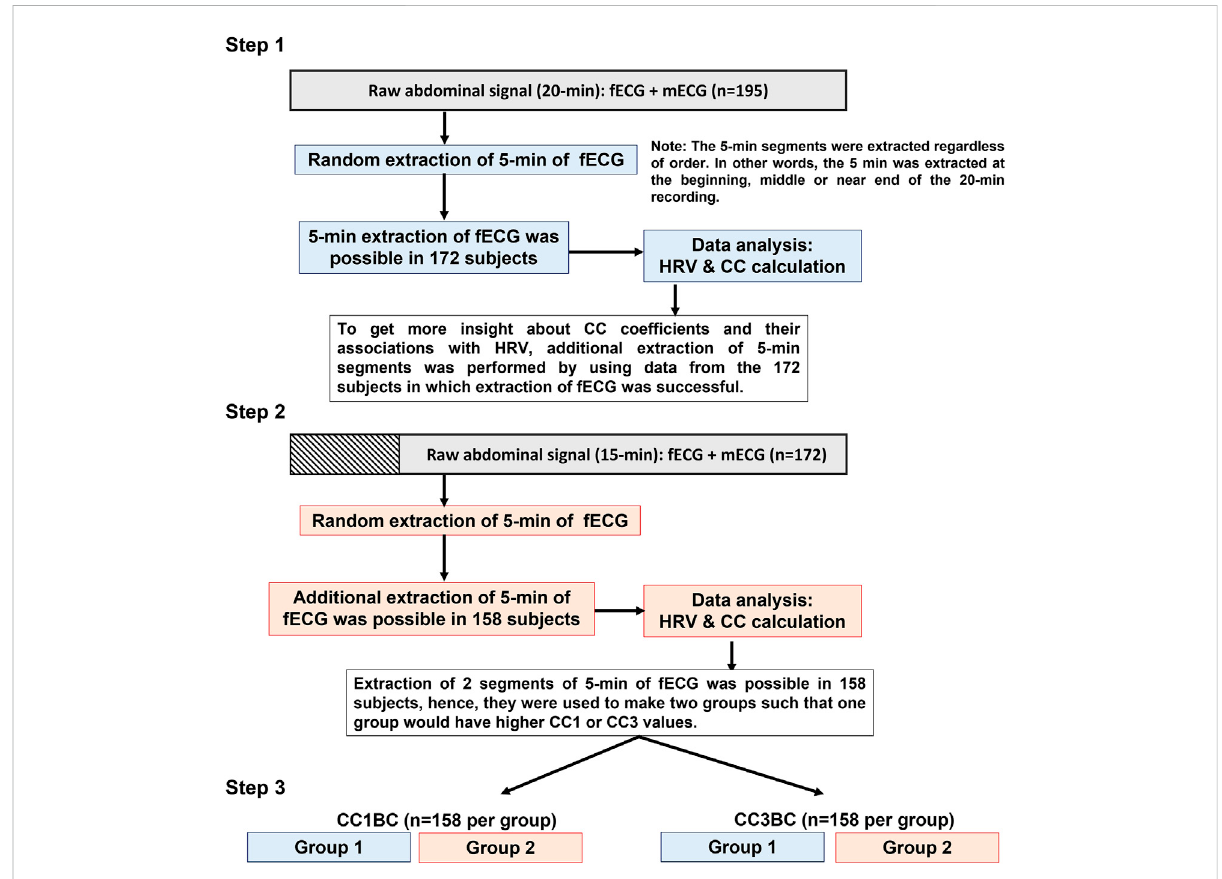
FIGURE 2 Summary of data analysis. The fl owchart provides a graphical summary of the steps that were followed to analyze the data. In Step 1, 5-min extraction of fetal electrocardiogram (fECG) was successful in 172 out of 195 subjects. In step 2, additional extraction of 5-min segments was successful in 158 out of the 172 subjects. Both in step 1 and step 2 cross-correlation (CC) and maternal and fetal heart rate variability (HRV) analyses wereperformed for theextracted 5-min segments. In step 3, acomparison ofmeansanalysiswas performed to comparebetween group 1and group 2 in terms of maternal and fetal HRV analysis. Group 2 has higher CC1 or CC3 values compared to group